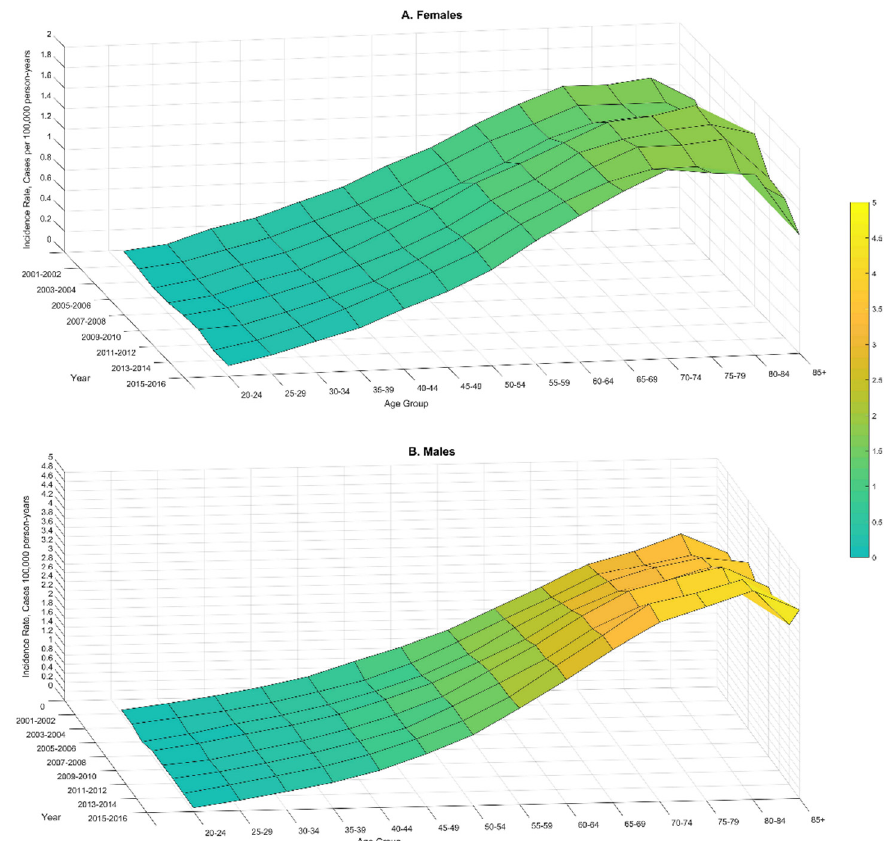
Figure 1. Three-dimensional visualization of age-specific incidence rates of liposarcoma among males and females during the period of 2001–2016 from the combined Surveillance, Epidemiology, and End Result and National Program of Cancer Registries (CNCPR) data.